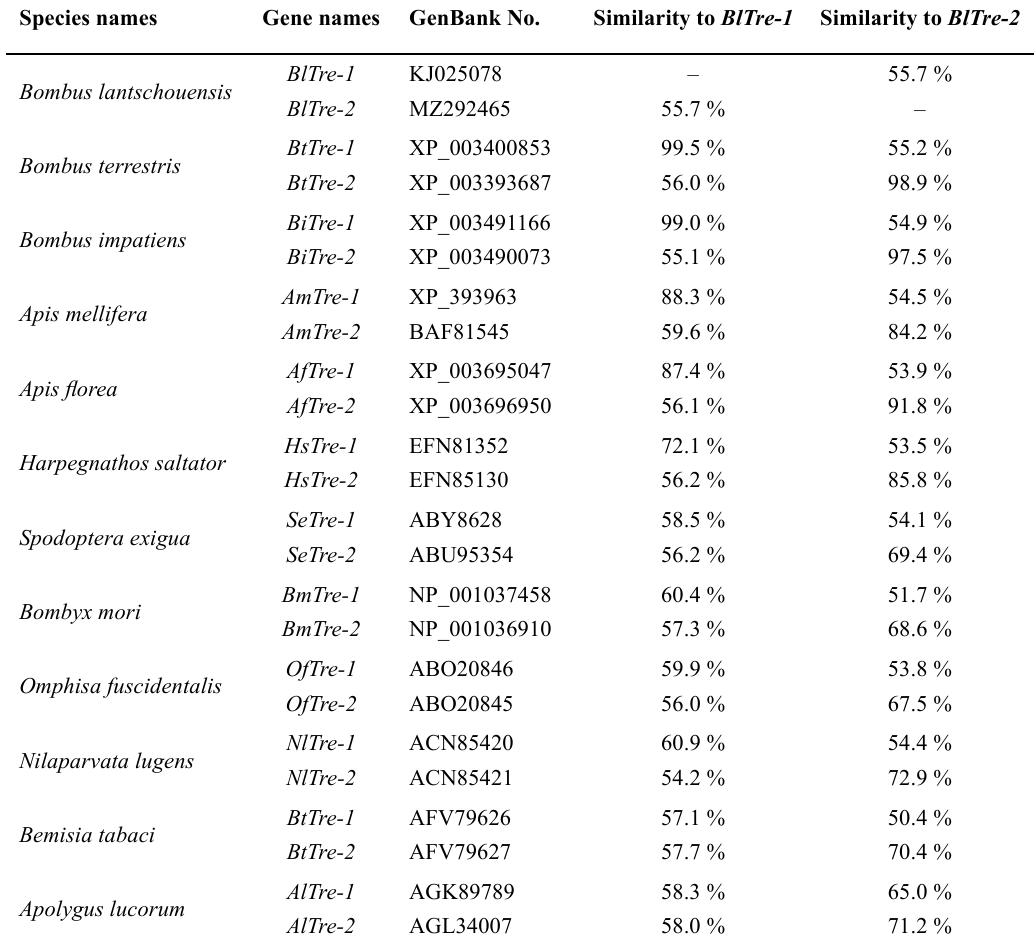
Table 3 . The similarity comparison between amino acid sequences of trehalase genes from B. lantschouensis and other